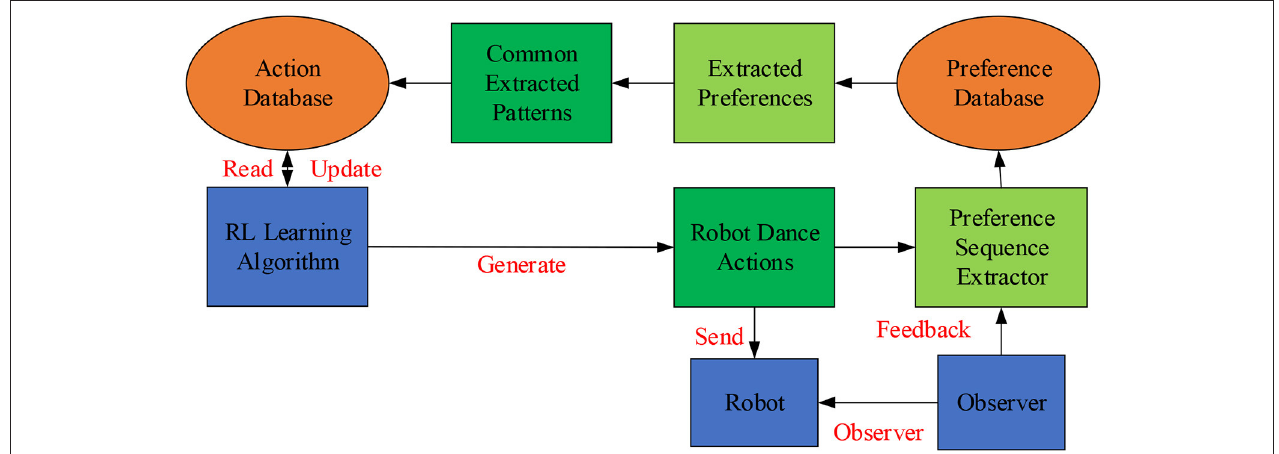
FIGURE 1 | Principle of dancing robot-imagined choreography with enhanced interactive